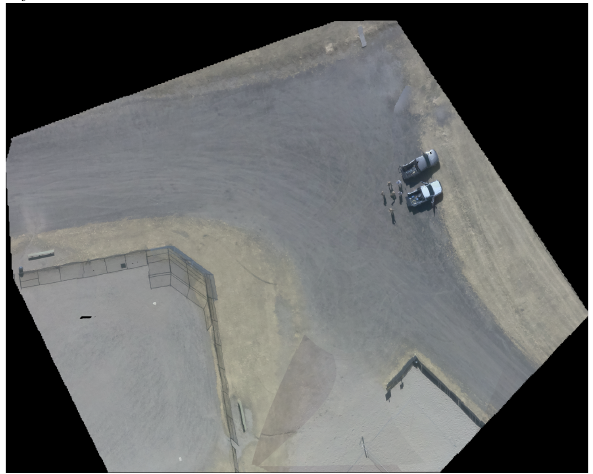
Figure 5. KML of averaged temperature readings visualized as a line.